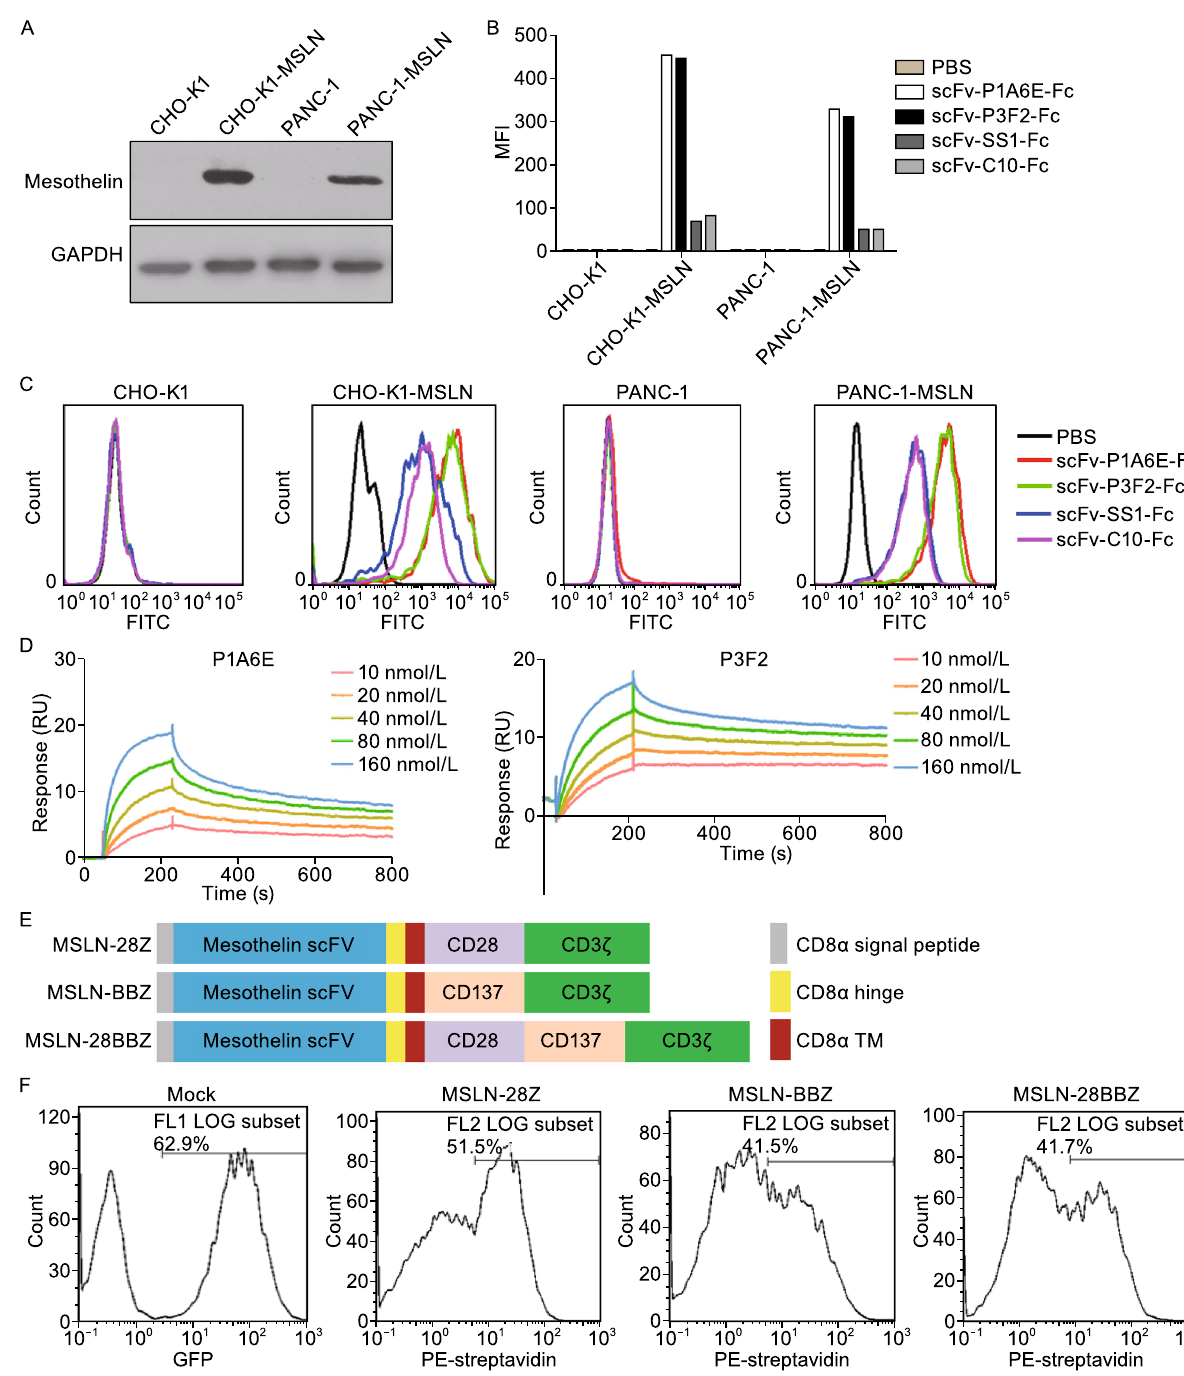
Figure 1. Binding properties of anti-mesothelin antibody and CAR constructs on primary human T cells . (A) Mesothelin expression in the established cell lines. Cell extracts from mesothelin-transfected cells were subjected to Western blot analysis. The blot was incubated with a mouse monoclonal antibody mesothelin (K1). GAPDH was used as a loading control. (B) The mean fl uorescence intensity (MFI) of different scFv proteins bound cells was determined by fl ow cytometric analysis. (C) Binding speci fi city of the anti-mesothelin antibody to MSLN-transfected CHO-K1 or PANC-1 cells. (D) Af fi nity measurements of antibody binding to mesothelin through Biacore Surface Plasmon resonance. (E) A schematic diagram showing the MSLN-speci fi c CAR used in this study. (F) The primary human T cells ef fi ciently express MSLN-speci fi c CAR, as measured by fl ow cytometry. Mock T cells were demonstrated by assessing the expression of